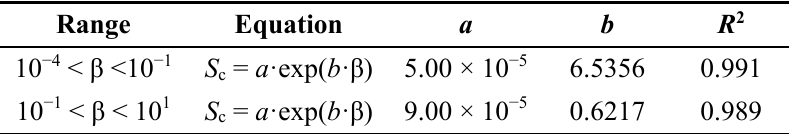
Table 2. Two-step regression equation between catchment slopes ( S c ) and the Gibbsian model ( β ) (rainfall intensity = 15